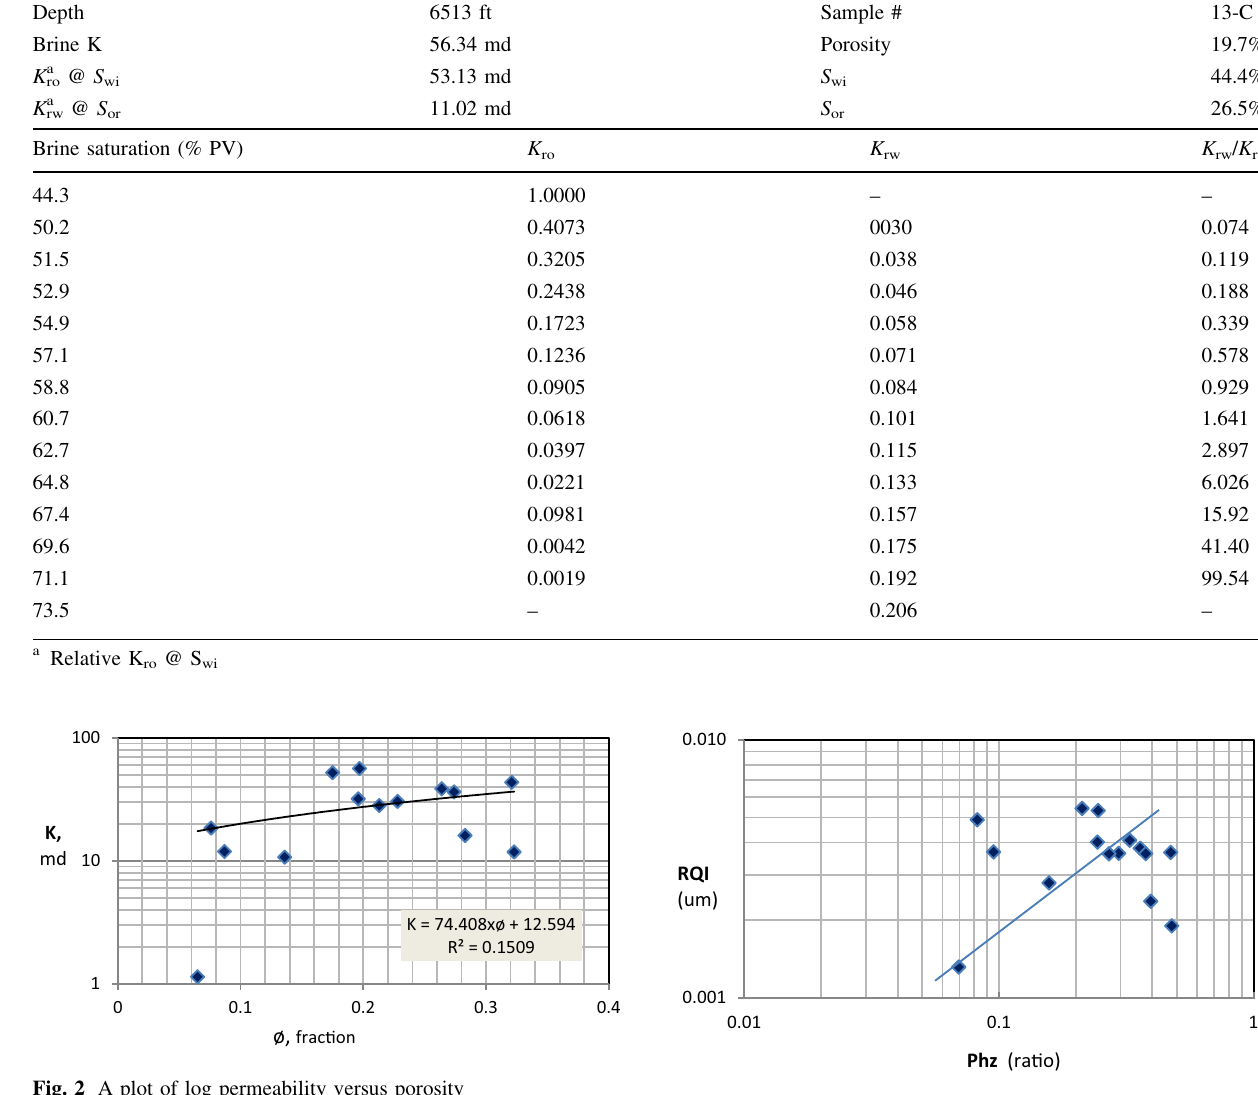
Fig. 3 Log-log plot of RQI versus u